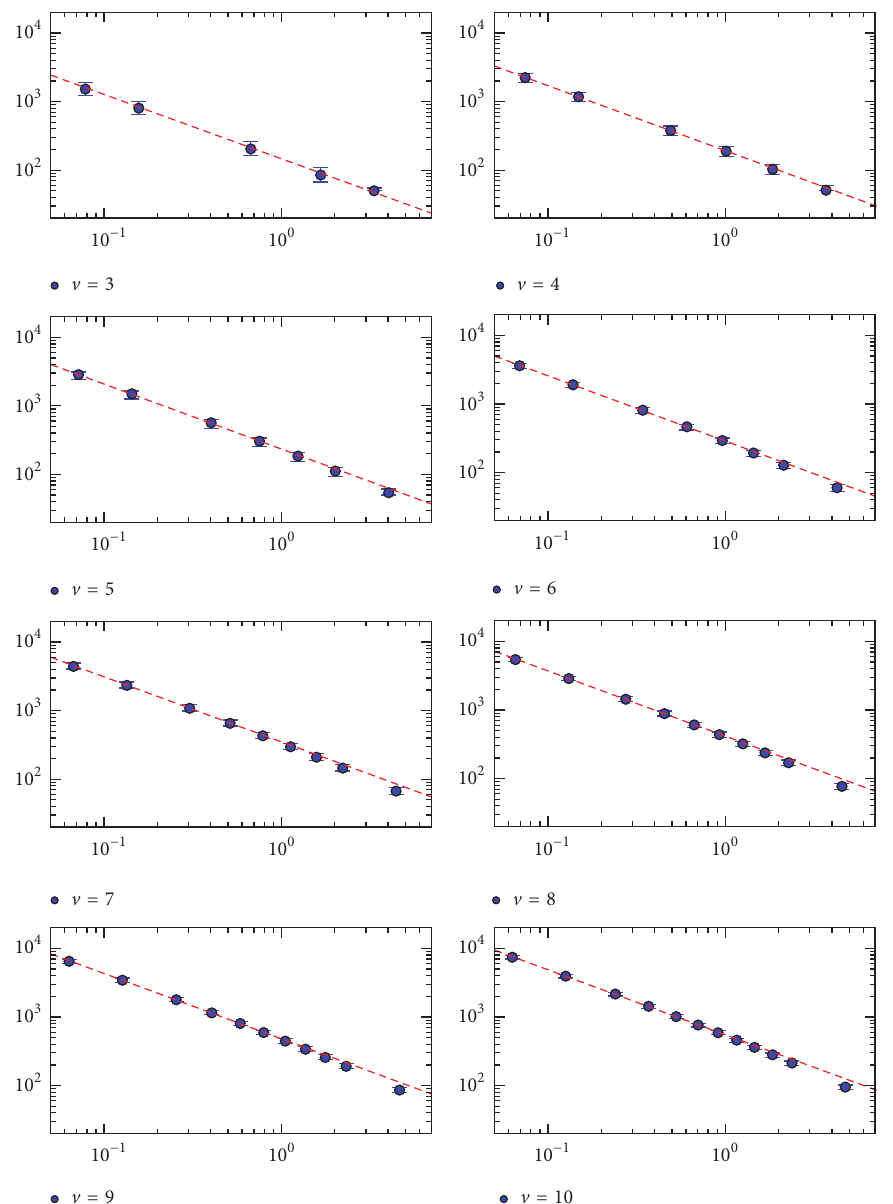
= 1.0×10 −7 . The parameter 𝜌 has been chosen as in Table 1. The (red) dashed Figure 6: Log-log plots of 𝑛 versus 𝜌 in the GJOR scheme at 𝜖 it T line in each plot represents our best jackknife linear fit to (76) of data points with 𝜌 ≲ 1